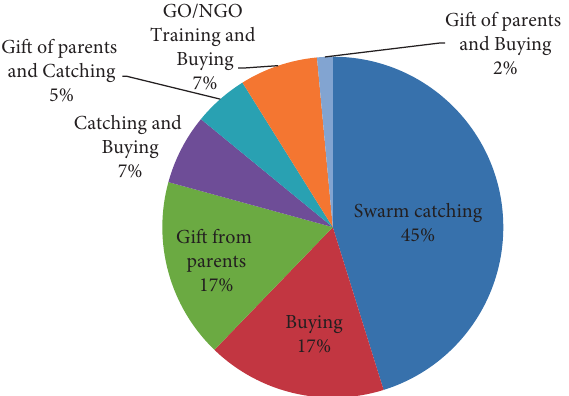
Figure 1: Source of starter bee colony in the study